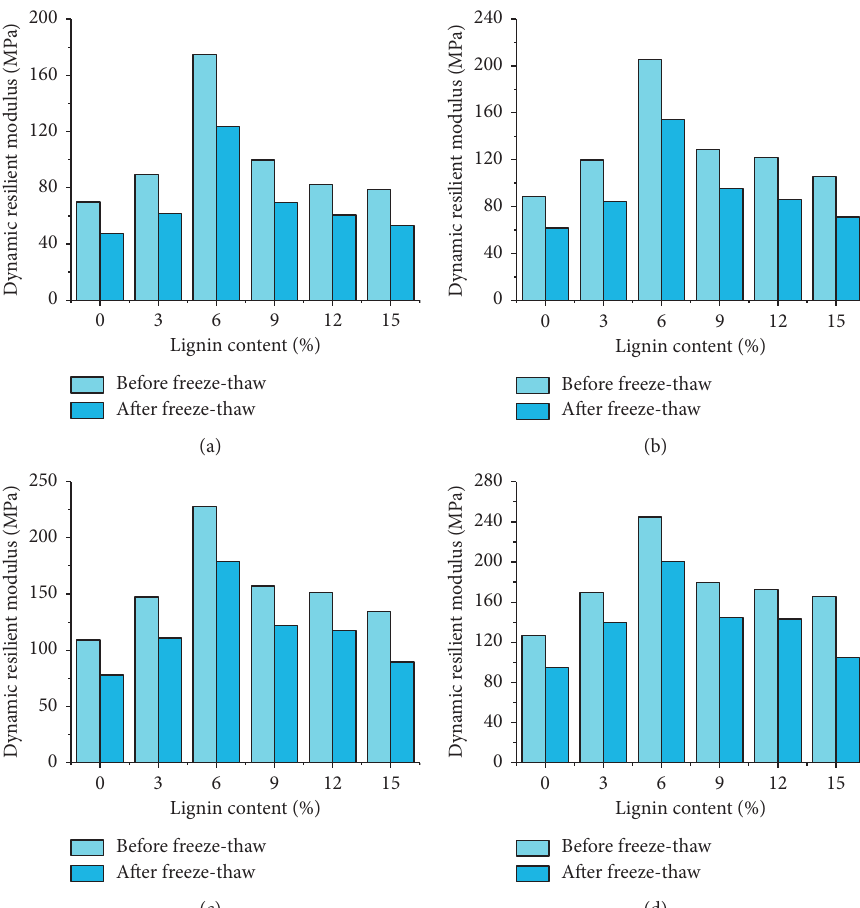
Figure 9: Effect of freeze-thaw and lignin content on dynamic resilient